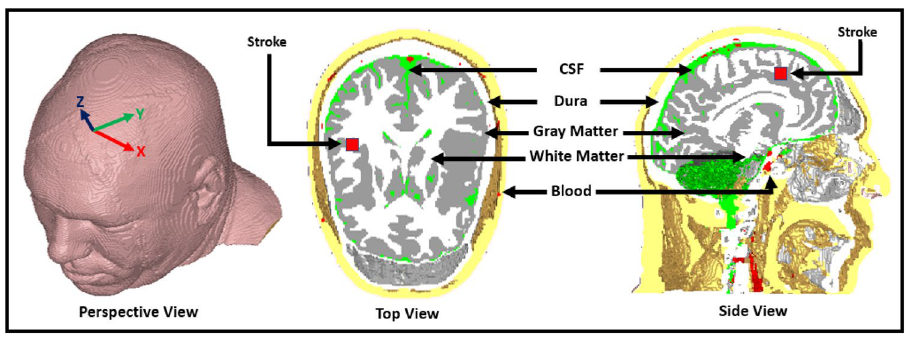
Figure 1. Layout of human head (Hugo